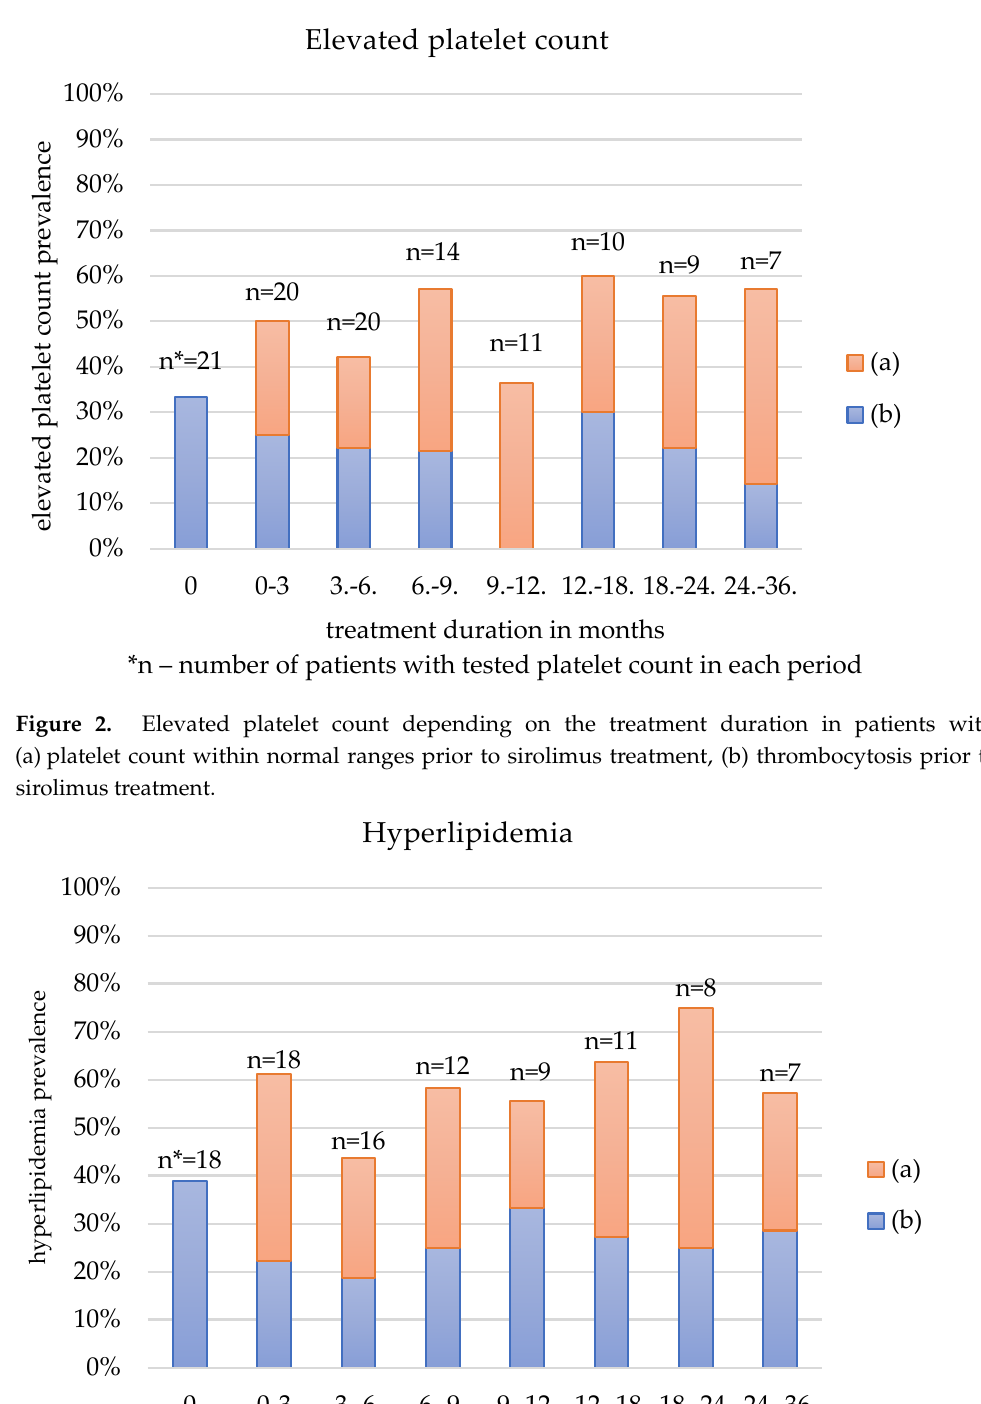
Figure 3. Hyperlipidemia depending on the treatment duration in patients with: (a) normal lipid blood levels prior to sirolimus treatment, (b) hyperlipidemia prior to sirolimus treatment.